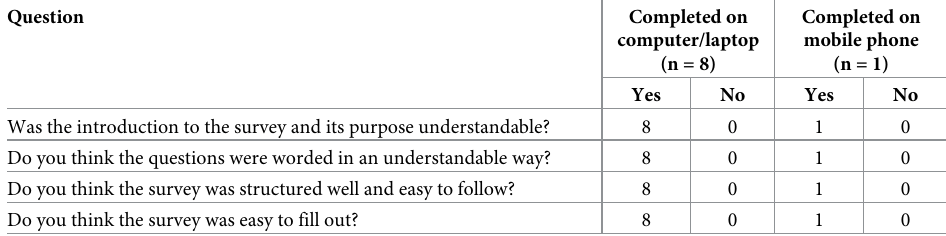
Table 1. Feedback from pilot survey (n =